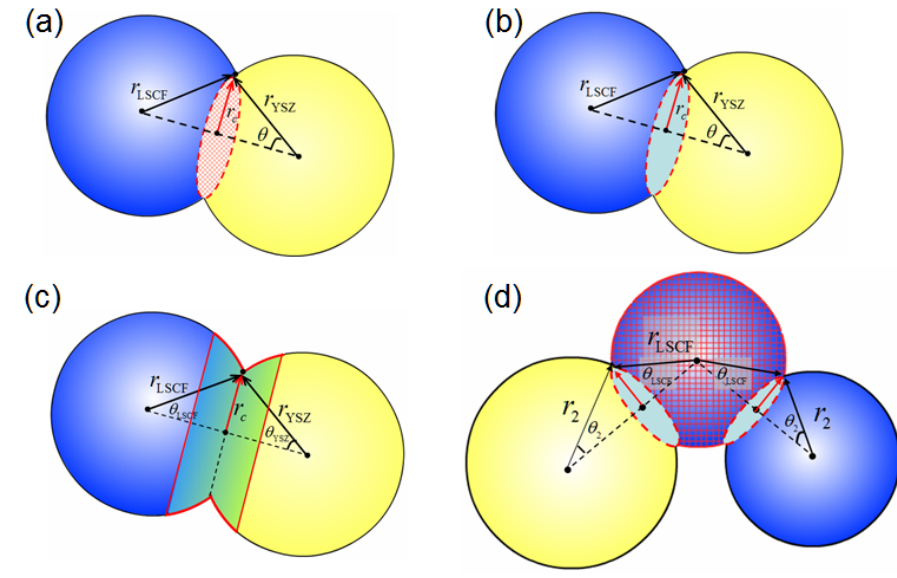
Figure 4. Illustration of the four different assumptions of the electrochemical reaction sites: ( a ) the 2D contact area at the contact intersection, ( b ) the 1D circular length around the contact intersection, ( c ) the particle surfaces within a finite distance of the contact circular length and ( d ) the exposed surface area of each LSCF